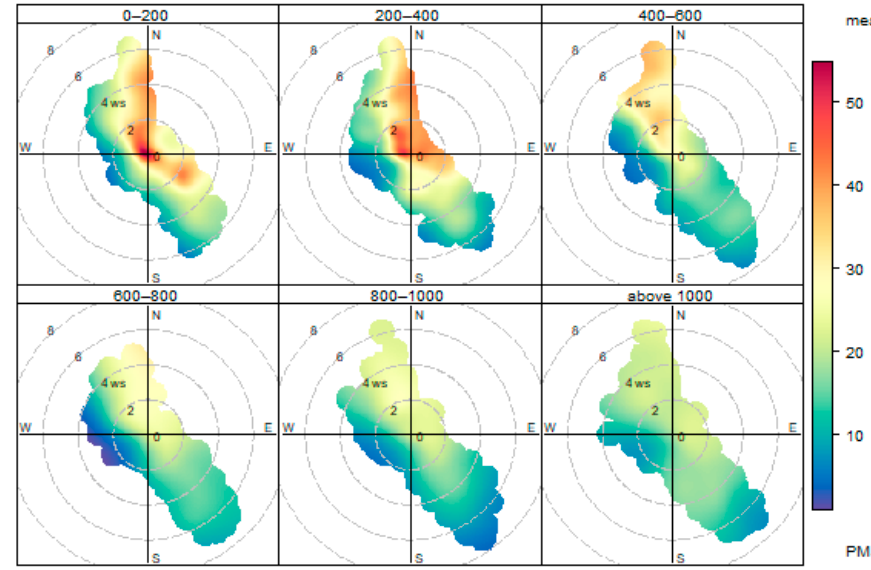
Figure 19. Average PM 10 concentration roses divided according to the mixing layer height, T ř inec- Kosmos site, 2016–2019.